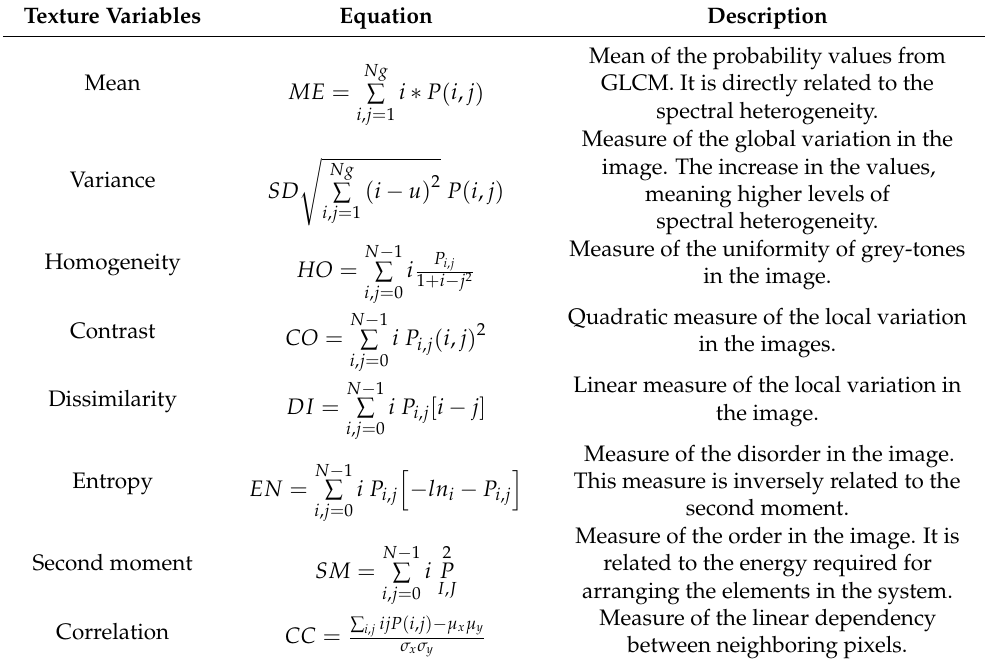
Table 5. Texture variables derived from